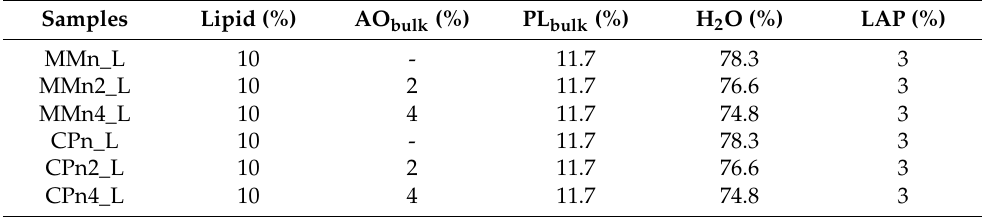
Table 1. Composition (%, w/w ) of hybrid nanostructured lipid carriers/clay.